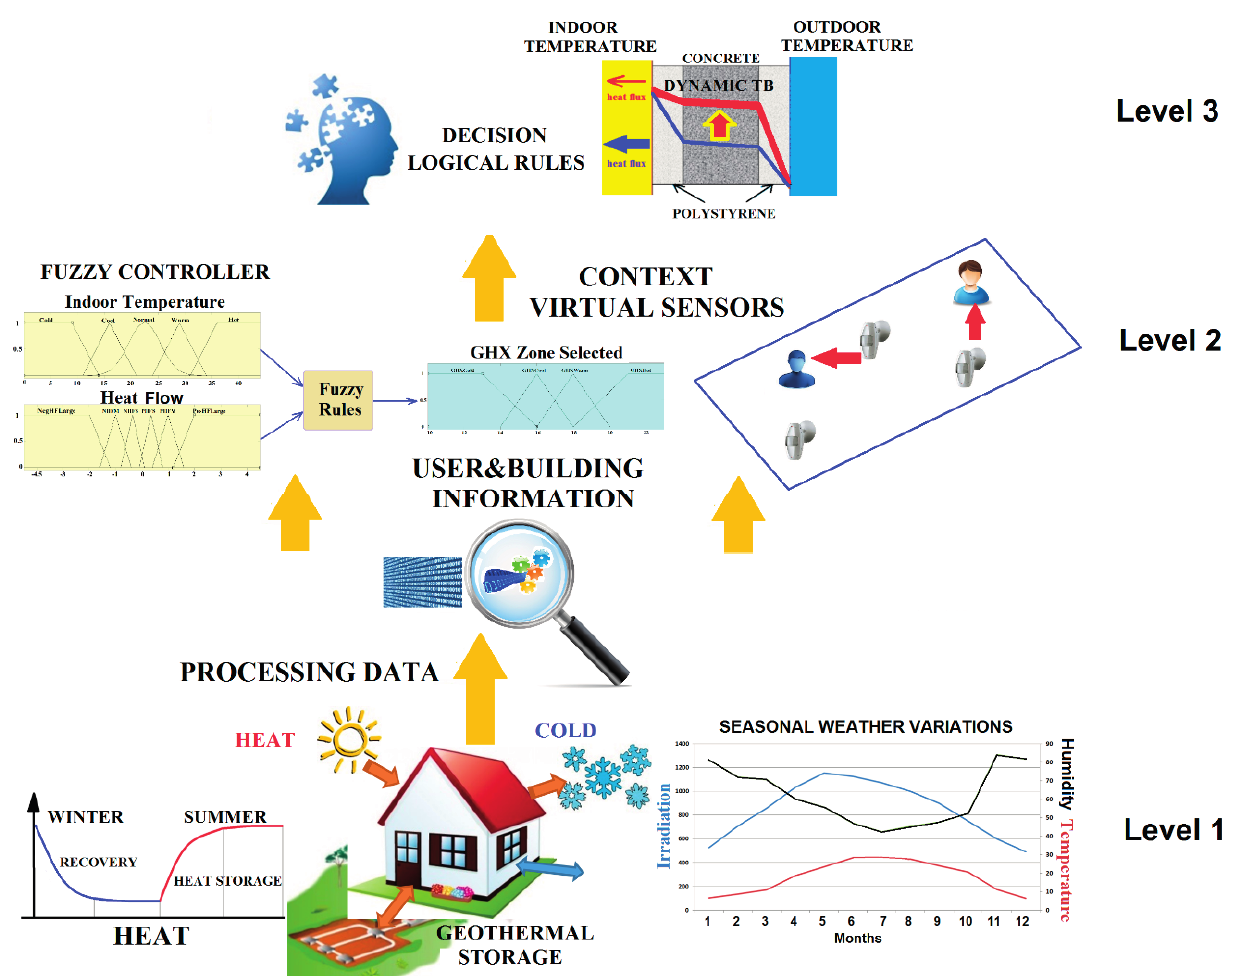
Figure 10. Three level perception and decision making architecture for thermal energy flow